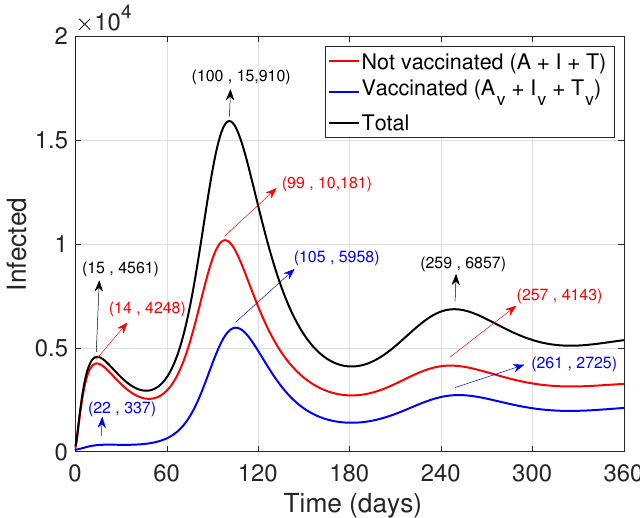
Figure 2. Dynamics of the vaccinated and unvaccinated infected, that is, adding asymptomatic patients, with symptoms, and who are undergoing health treatment. The initial values are S ( 0 ) = 99,000, S v ( 0 ) = 100, E ( 0 ) = 500, E v = 100, A ( 0 ) = 100, A v ( 0 ) = 85, I ( 0 ) = 100, I v ( 0 ) = 10, T ( 0 ) = 0, T v ( 0 ) = 0, R ( 0 ) = 5, R v ( 0 ) = 0, P ( 0 ) = P ∗ , and P v ( 0 ) = P ∗ v